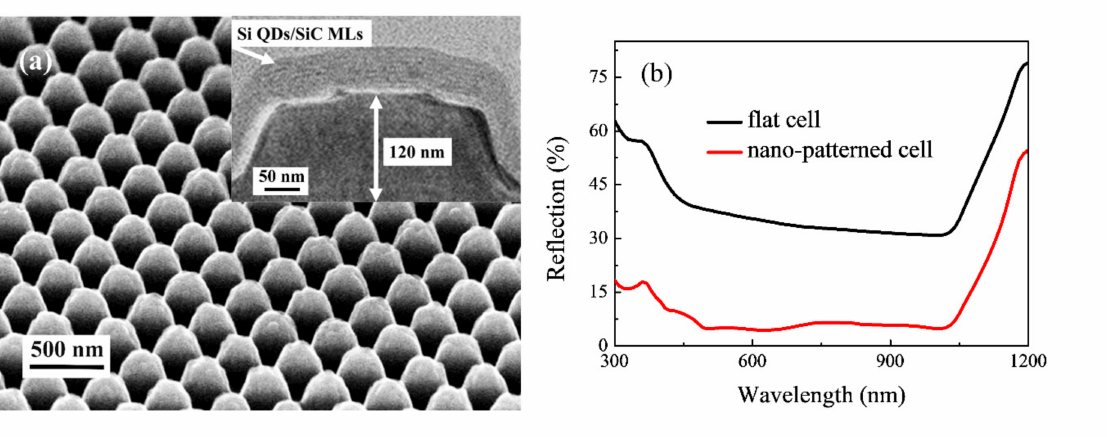
Figure 7. ( a ) SEM image of Si QDs / SiC MLs on the substrate of nano-patterned Si. Cross-section TEM image is in the inset of Figure 7a; ( b ) reflection spectra of Si QDs / SiC MLs-based solar cells on flat and nano-patterned